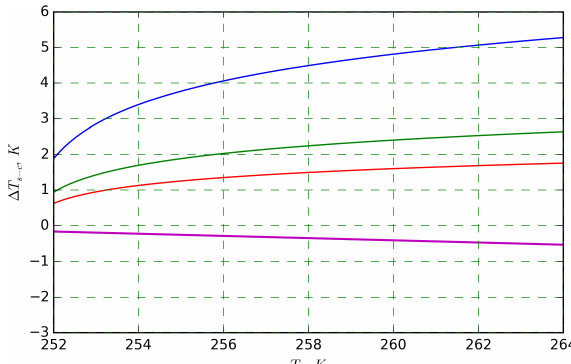
Figure B4. Temperature shift calculated for three different λ values (red: 0.8; green: 1.6; and blue: 2.4) in relation to temperature differ- ence between drop surface and volume-averaged drop temperature (magenta